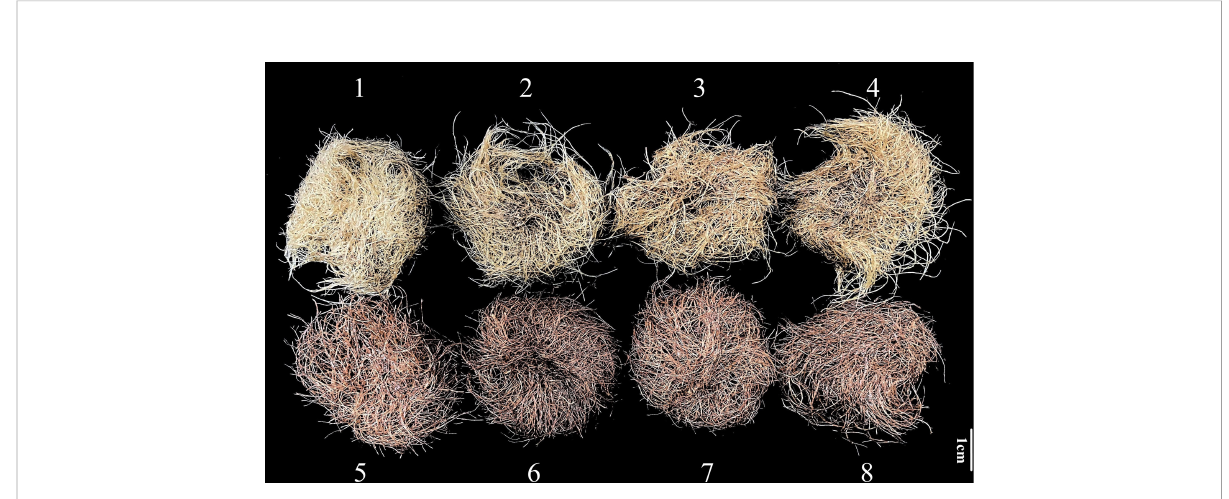
FIGURE 1 Culture of hairy roots of transgenic S. miltiorrhiza . (1-4) The blank control group. (5-8) The SmDXS5 overexpression